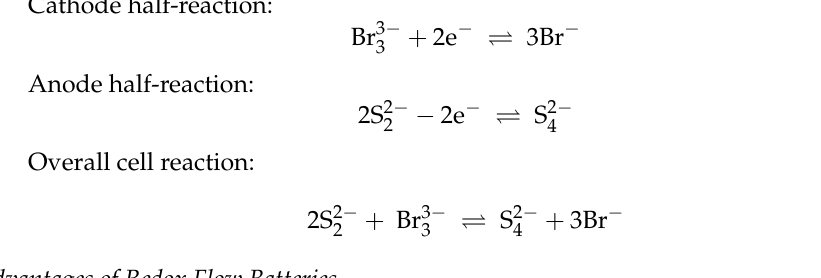
Figure 19. All-vanadium redox flow battery.